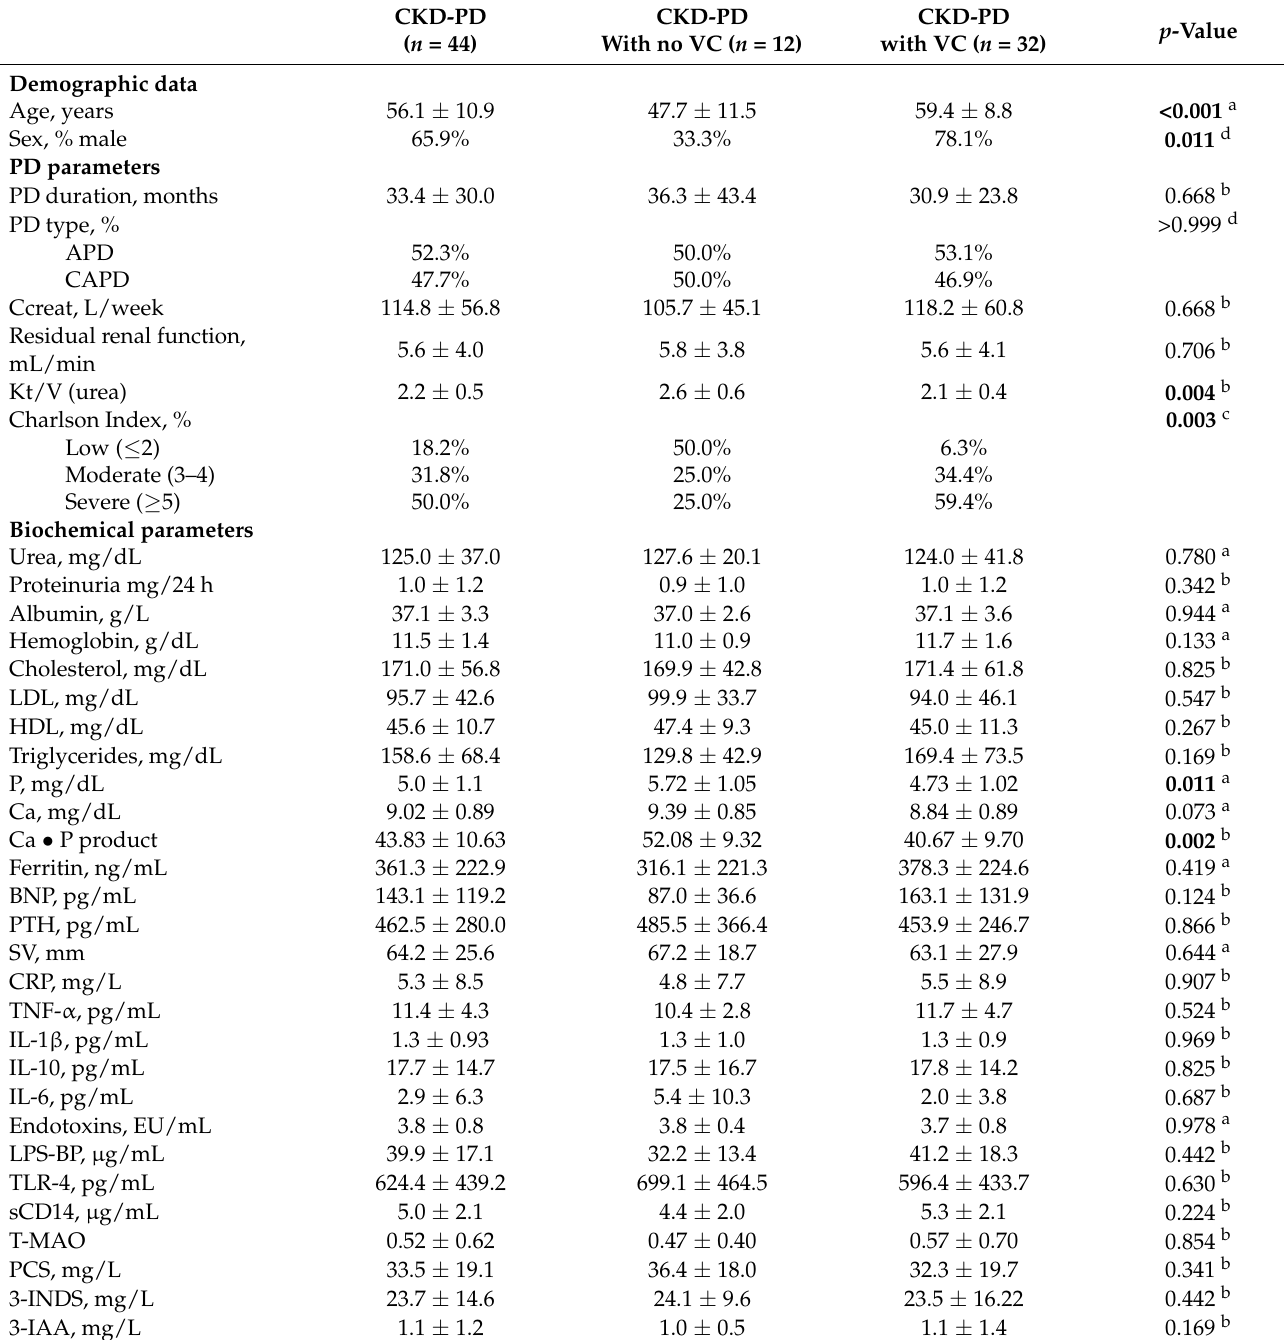
Table 1. Demographic and clinical characterization of chronic kidney disease patients on